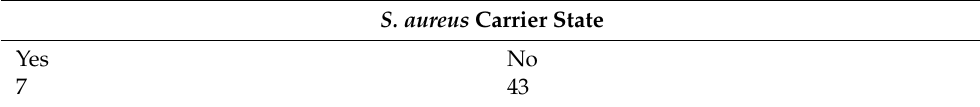
Table 3. S. aureus carrier state.